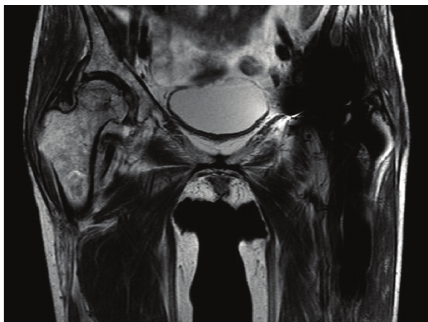
Figure 3: T1W mid-coronal section MRI showing osteonecrosis of the right femoral head.